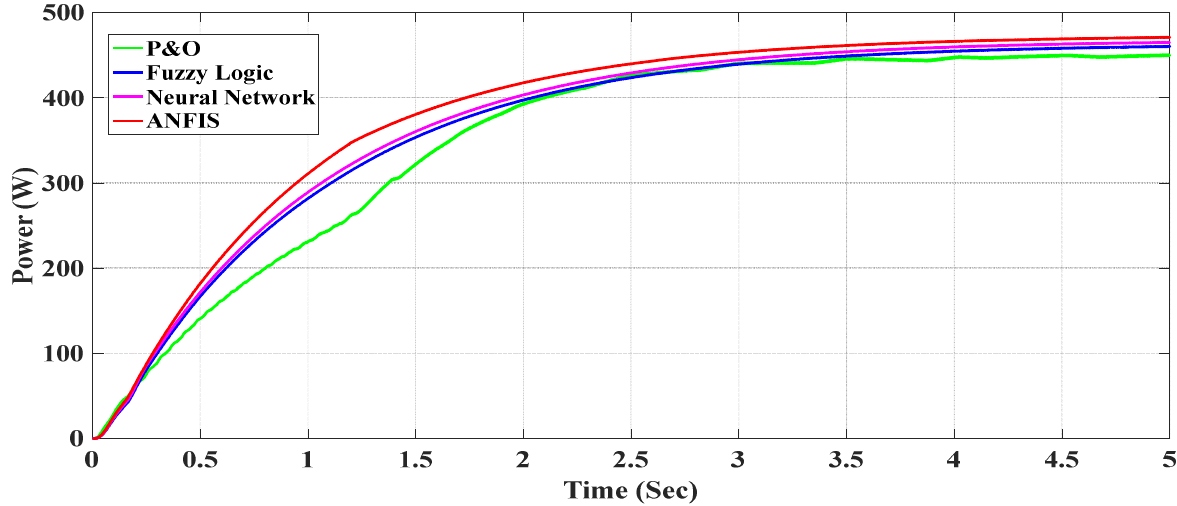
Figure 37. Output Power of PEM-FC using P-&-O, F-LC, AN-N and AN-FIS MPPT to the deviation in HFR.